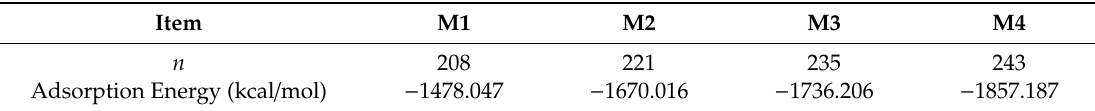
Table 4. The hydrogen bond number and adsorption energy of montmorillonites with di ff erent layer charge density.